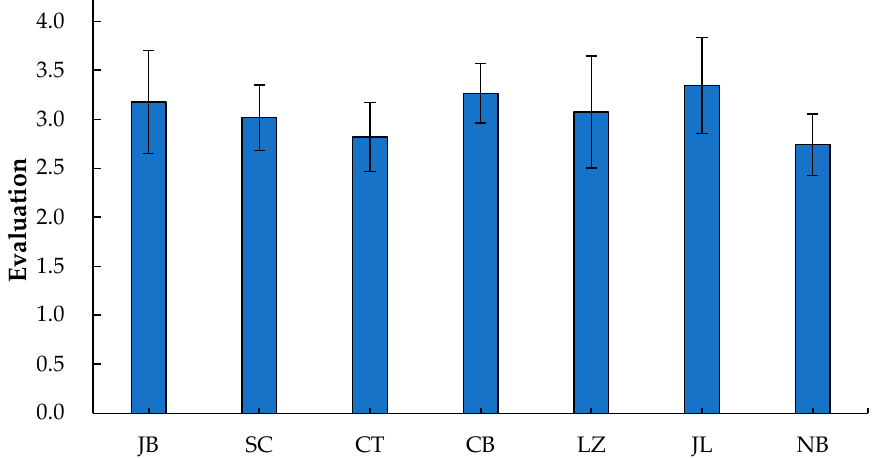
Figure 7. Evaluation results of SECD in seven WSMCs. SECD = smell environment comfort degree.